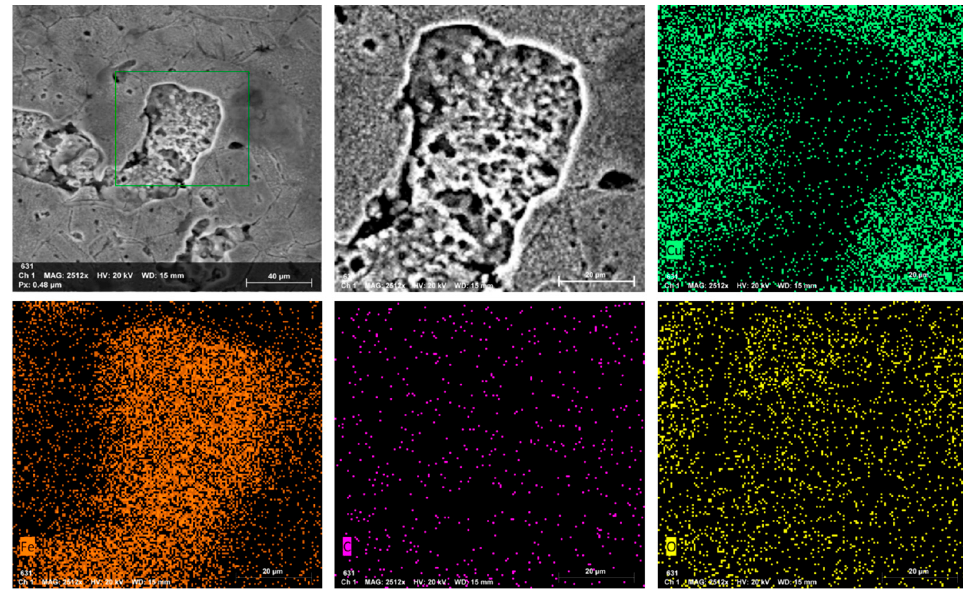
Figure 8. EDS distribution maps of the PW+SA sample at 200 MPa.